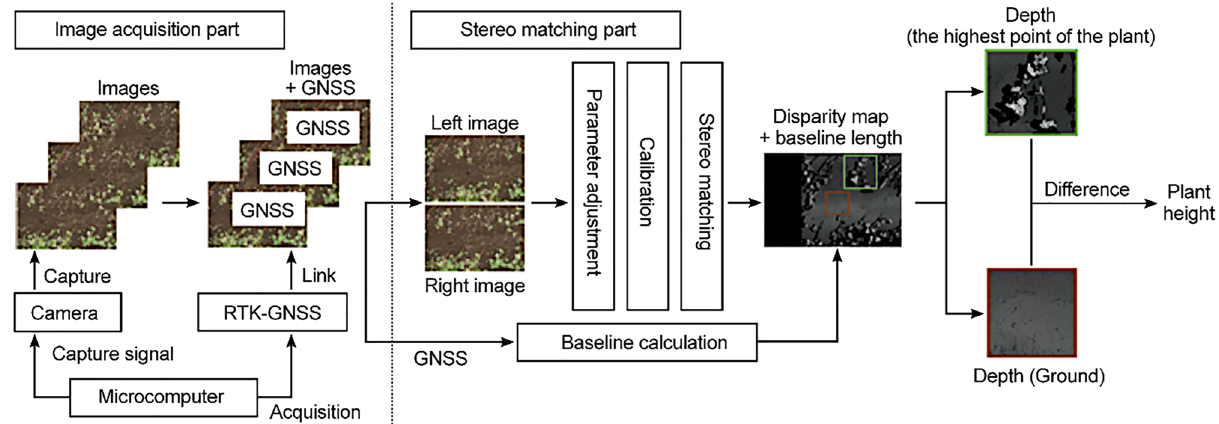
Figure 17. Process flow of the proposed